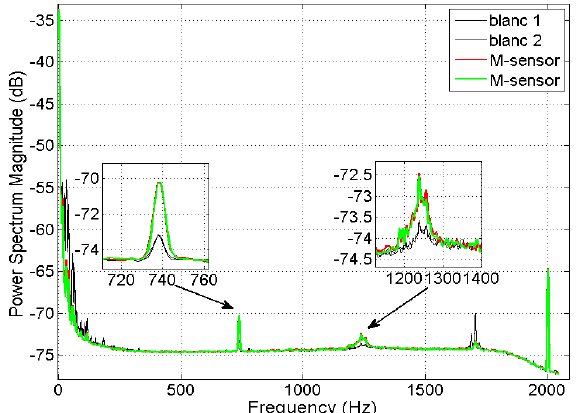
Figure 5. Power spectrum of response of two type-A (in green and red) and two -A blanc (in dark grey and black) slabs tested following procedure P1. Evidence that the hidden strip acts like a sensor are given in insets.